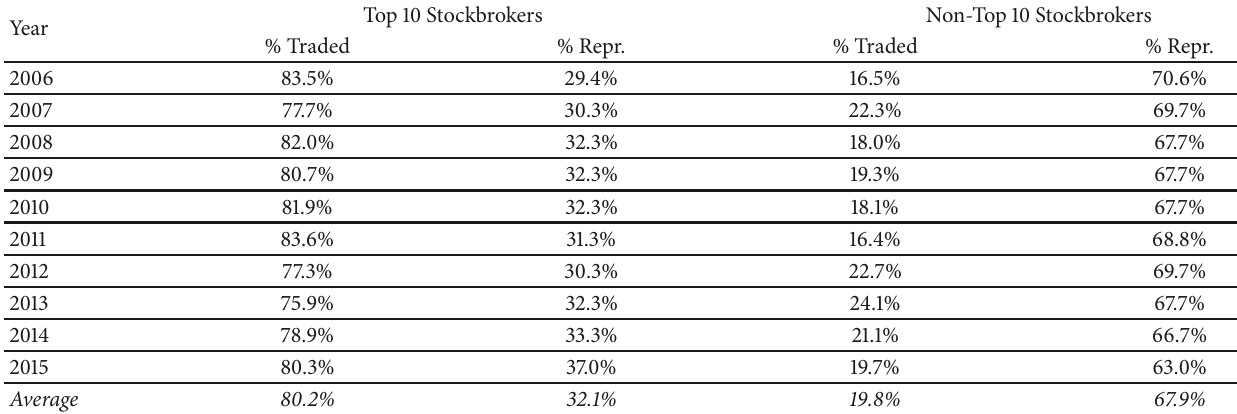
Table 1: Summary of stockbrokers